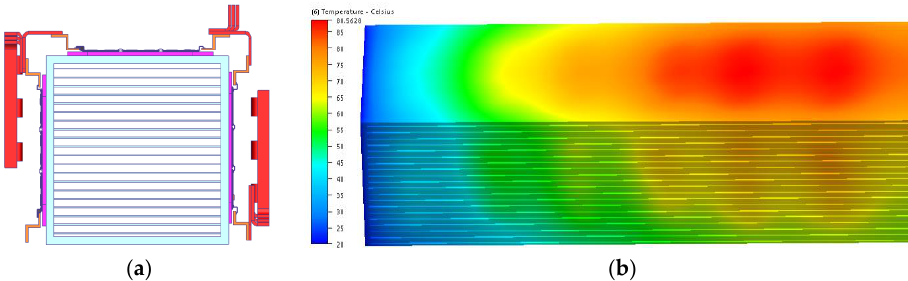
Figure 8. ( a ) Heatsink version I; and ( b ) its finite element analysis (FEA) results (maximum temperature on the heatsink surface: 89 °C).